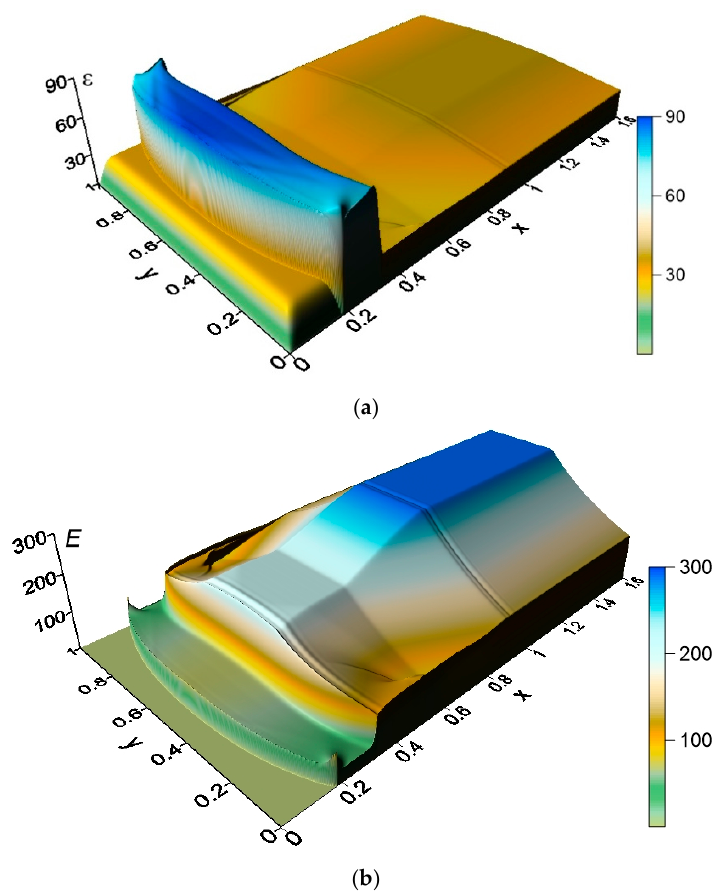
Figure 14. Fields of ε h ( a ) and E h ( b ), M = 8, α = 0.1, t = 0.12 .